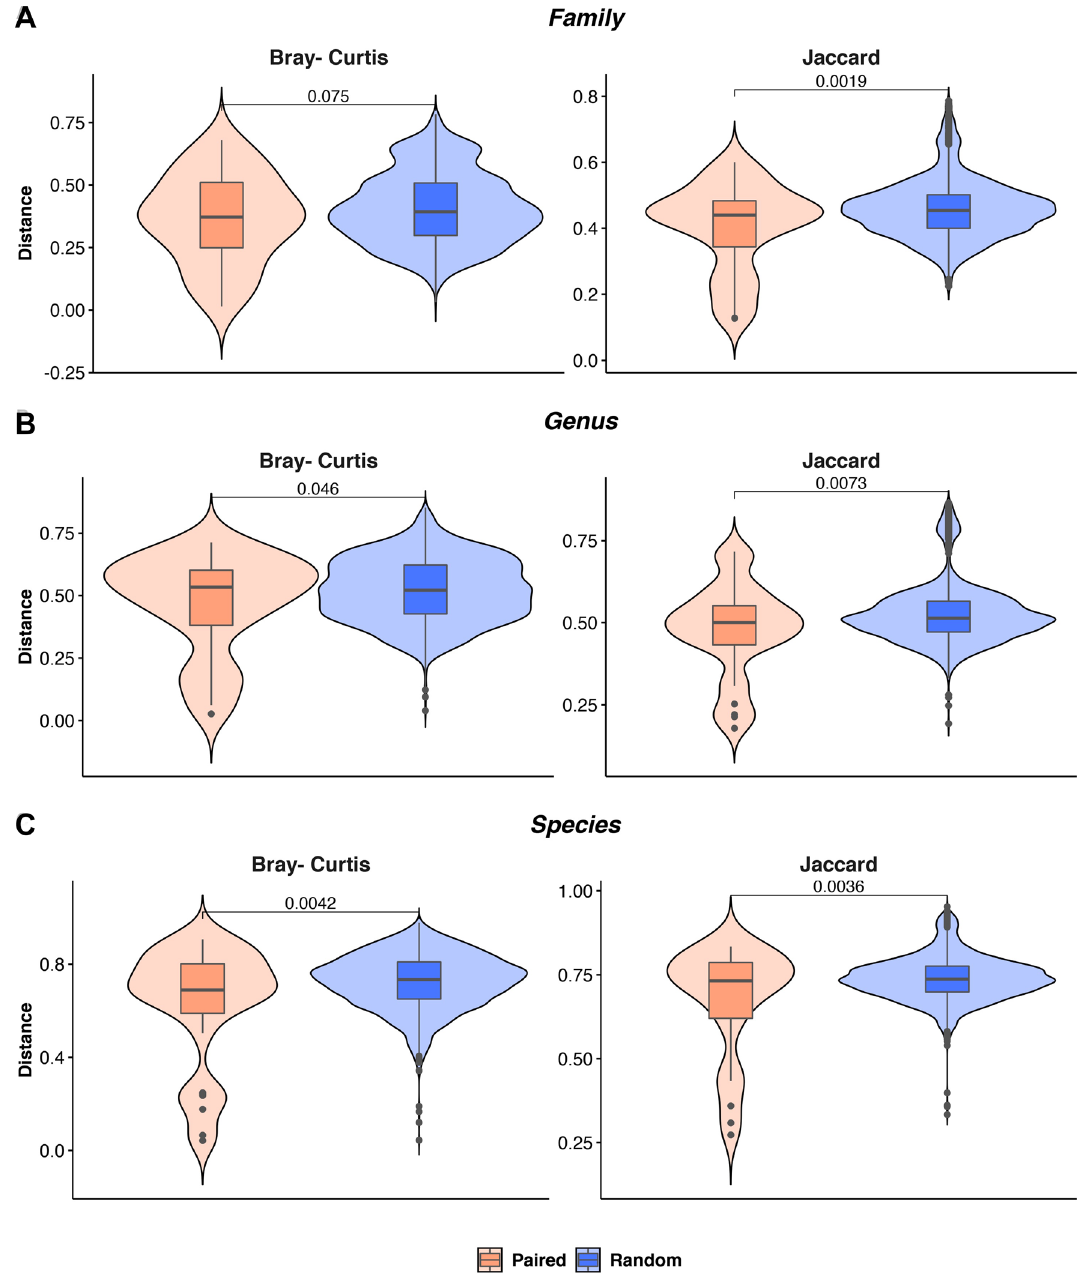
Figure 7. Violin plot showing the observed distances, measured by using both the Bray–Curtis and Jaccard metrics, among paired (i.e. samples belonging to the same individual but from different matrices) and random pairs at family, genus and species ranks. The resulting p-value is shown for each